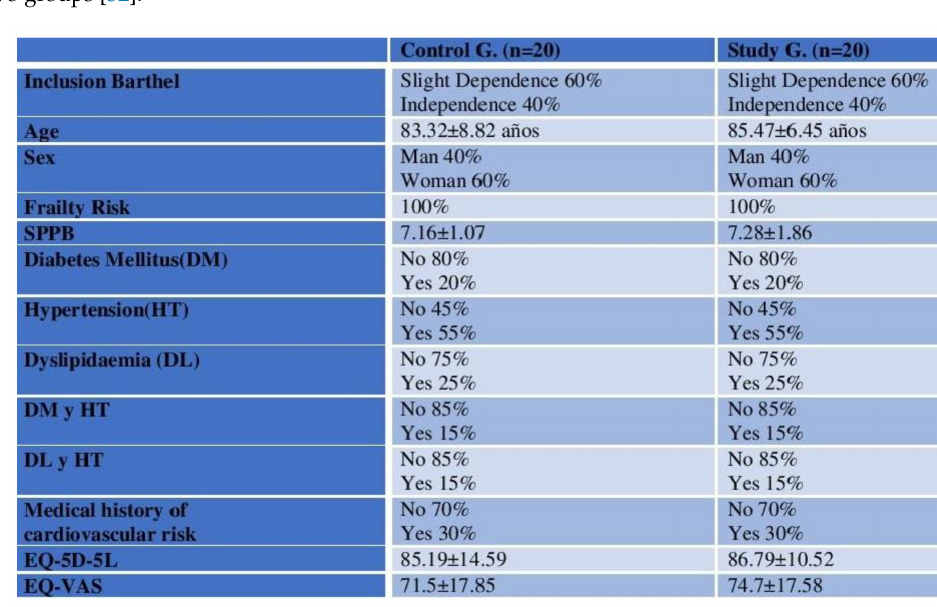
Figure 3. CONSORT Flow diagram of the progress through the phases of a parallel randomised trial of two groups [32].